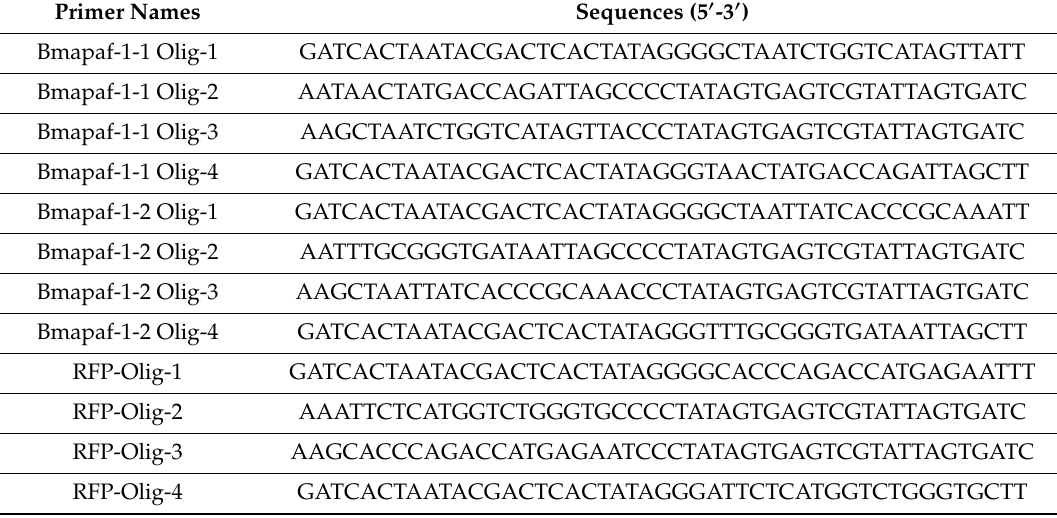
Table 2. Primers used to synthesize